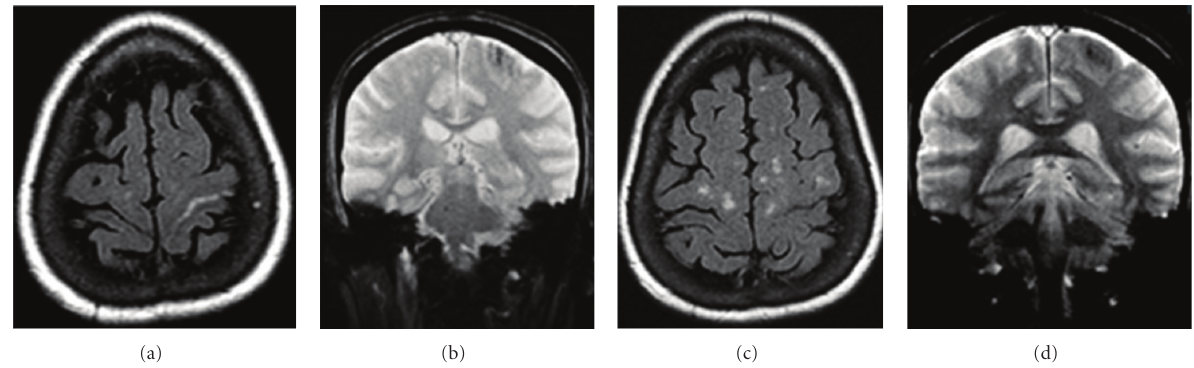
Figure 4: Second case of isolated central sulcus hemorrhage. MR images in a 67-year-old female with history of nasal cavity lymphoma presenting with right sided weakness. There is no history of trauma, hypertension, or bleeding diathesis. Flair MRI (image (a)) demonstrates isolated increased signal within the left central sulcus with corresponding loss of signal on gradient echo (image (b)) consistent with isolated central sulcus hemorrhage. Nonspecific white matter changes are seen on the FLAIR sequence (image (c)). MR angiogram did not demonstrate any aneurysms or vascular malformations. A probable diagnosis of cerebral amyloidosis was made based on the Boston criteria. Follow up MR images demonstrated interval resolution of the acute hemorrhage with chronic cortical and subcortical changes on the gradient echo sequences (image (d)).